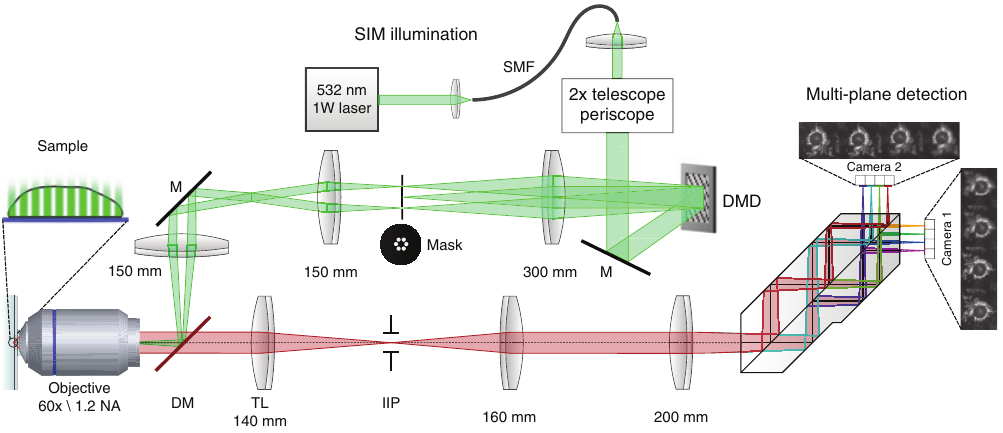
Figure 1: Optomechanical schematics of the high-speed multiplane SR-SIM imaging system. The SR-SIM pattern is created by a 532- nm 1-W laser (Roithner) coupled into a single-mode fibre for mode cleaning. The light at the distal end of the fibre is then collimated, expanded by a factor of 2 and directed onto a digital micromirror device (DMD), which is used as a fast, electronically controlled optical grating. A segmented aperture mask removes spurious diffraction orders, arising due to the binary nature of the DMD. A relay lens system focuses the light into the back focal plane of the objective lens (Olympus UPLSAPO 60 × /1.2 NA water immersion). Excitation and emission light is wavelength-separated by a dichroic mirror (DM). In the detection path, the tube lens (TL) forms an intermediate image ( image plane ), where a field stop (IIP) sets the field-of-view size and prevents overlapping signals in the multiplane detection system. A magnification of × 58.5 is achieved, which corresponds to a projected pixel size of 111 nm for the sCMOS cameras (ORCA Flash 4.0, Hamamatsu). Lenses form a relay telescope into the main component, the precision-made multiplane prism [16]. It provides 2 × 4 copies of the image onto two scientific sCMOS cameras, where each copy has a defined path-length difference and thus defined axially offset focal